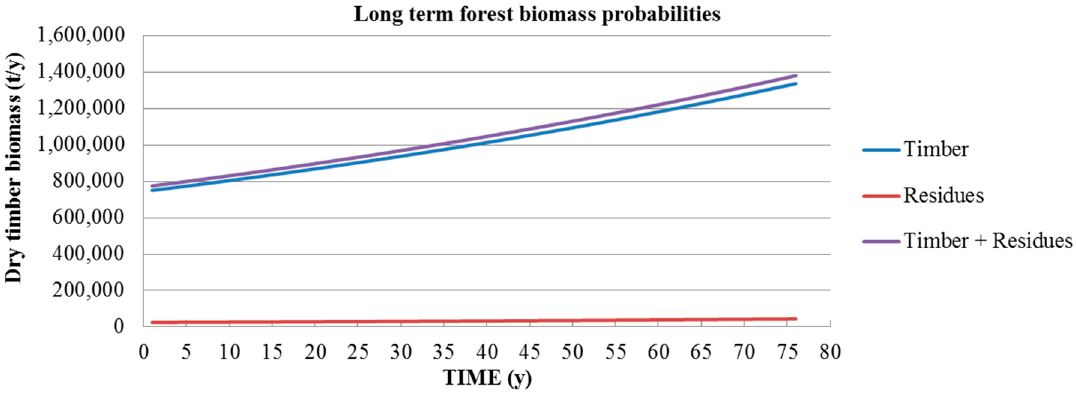
Figure 4. Long term forest biomass probabilities in Michigan.